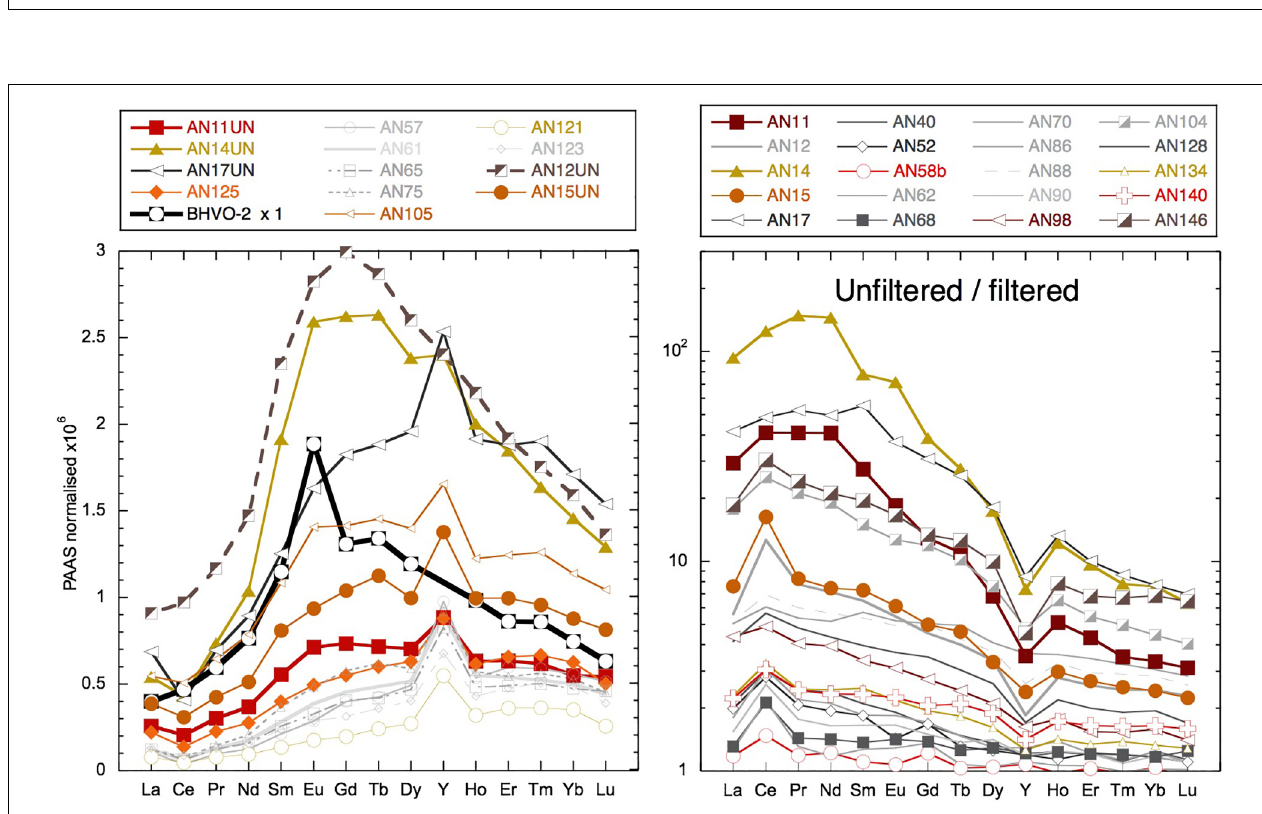
FIGURE 12 | Left: unfiltered seawater samples and BHVO-2 basalt values (taken from GeoReM database Jochum et al., 2005) normalized to PAAS (Nance and Taylor, 1976). Right: unfiltered YREE/filtered YREE for various examples. Samples from the main locations use the same symbols: squares for Smith Island, vertical triangles for Avis Island, square rhombuses for Niel (Shaheed Dweep) Island, and horizontal triangles for Little Andaman Island.